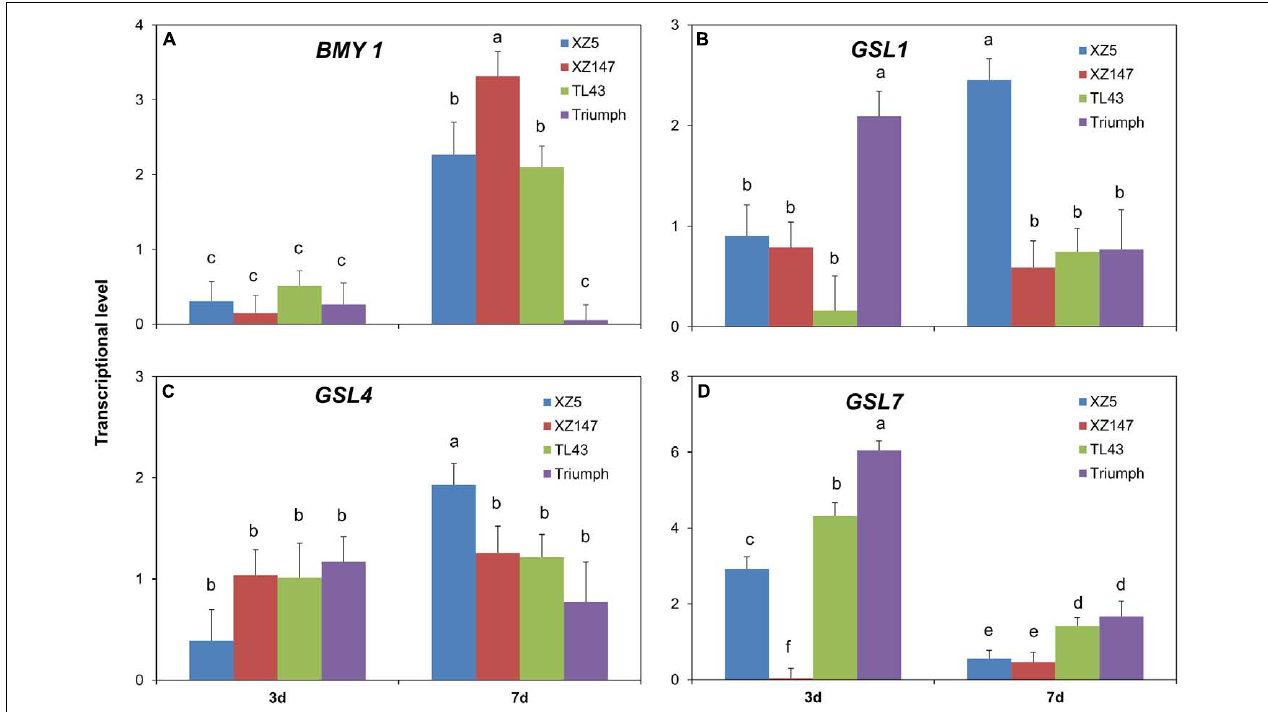
FIGURE 6 | Changes in transcriptional levels of BMY1 (A) , GSL1 (B) , GSL4 (C) , and GSL7 (D) in caryopsis of different barley genotypes after onset of water stress for 3d and 7d. GSLs , β -glucan synthase genes and BMY1 , β -amylase gene 1. Different letters indicate the significant difference at 95% probability. Data are mean ±